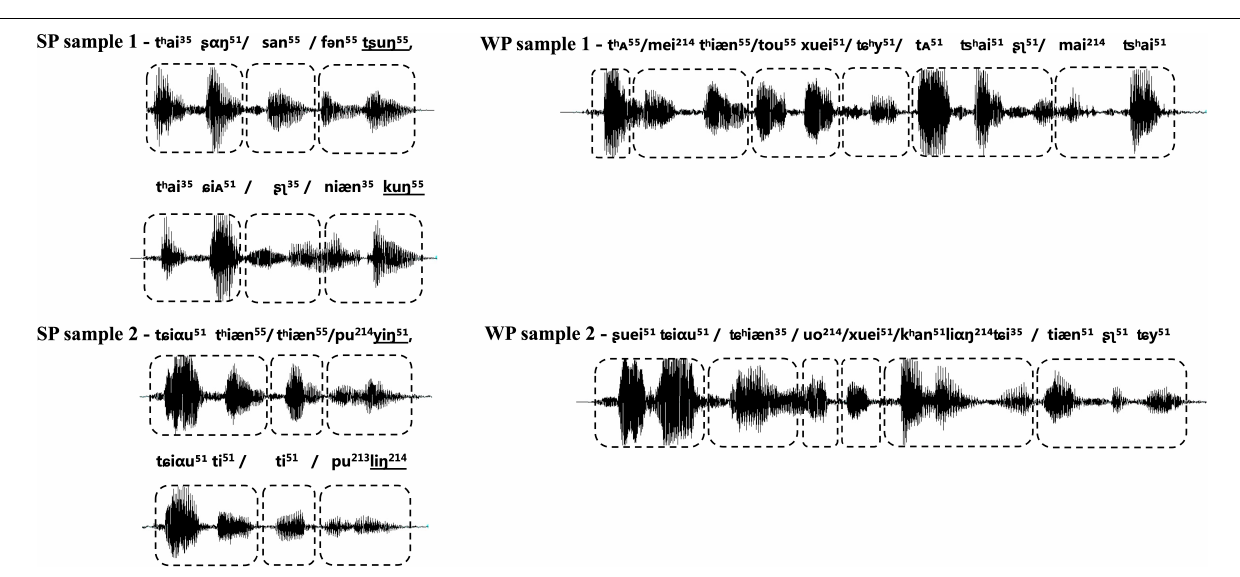
FIGURE 2 | Waveform of samples from two types of experimental stimuli, with strong-prosodic (SP) in the left column and weak-prosodic (WP) in the right one. The boxes with dashed lines indicate the meters of the sentence. The shapes of sound waves show the parallel construction of rhythm and stress within each SP, together with parallel meters as indicated by the boxes with dashed lines; the ending syllables in the two parallel clauses rhyme with each other, as shown by the underlined international phonetic signs in SP